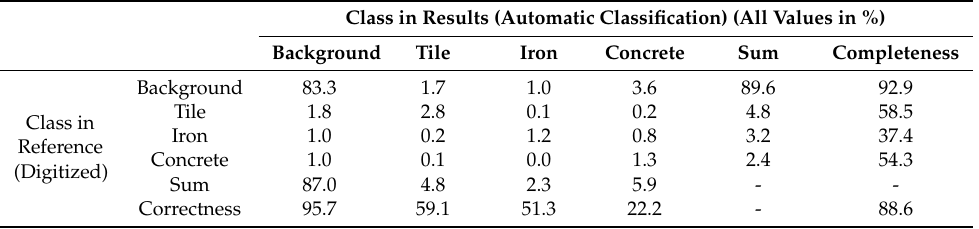
Table 10. Confusion matrix based on selected pixels in the classified image.